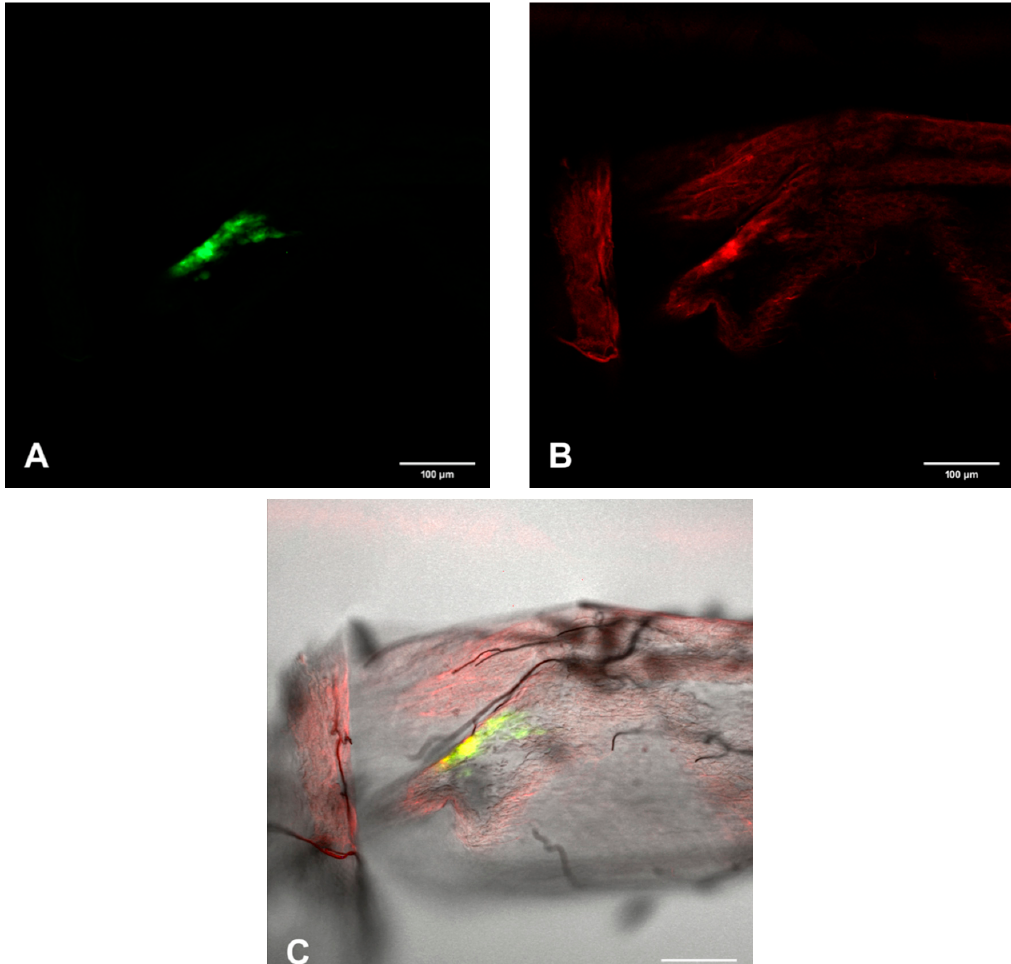
Figure 4. ( A ) Fluorescent laser confocal images of TX-Red FMRFamide positive ECs and ( B , C ) sequential images of a SINV-GFP (green) foci extending from front to back of the MG. ( D ) Overlay image of the GFP infection foci (B) and TX-red stained EC image (A) results in merged image. Midgut of a female Ae. aegypti dissected on day 5 p.i. and GFP SINV infection focus did not colocalize with FMRFamide-positive ECs. 200×.